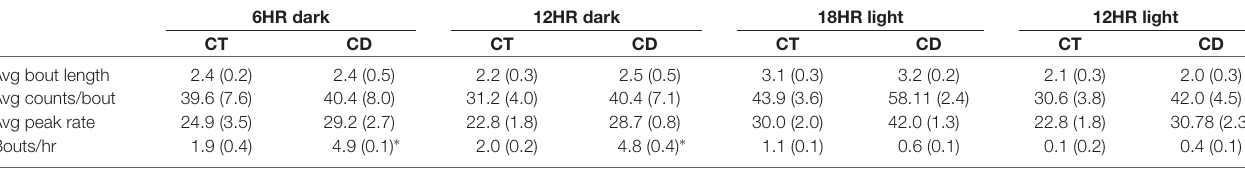
TABLE 4 | Bout analysis of water drinking by photoperiod in the 18HR environmental CD.